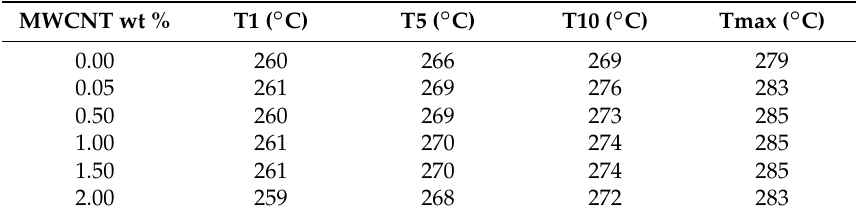
Table 2. Temperatures at 1, 5 and 10% weight loss (T1, T5 and T10, respectively) and temperature at the maximum weight-loss rate (Tmax) as a function of MWCNT content in the nanocomposites of